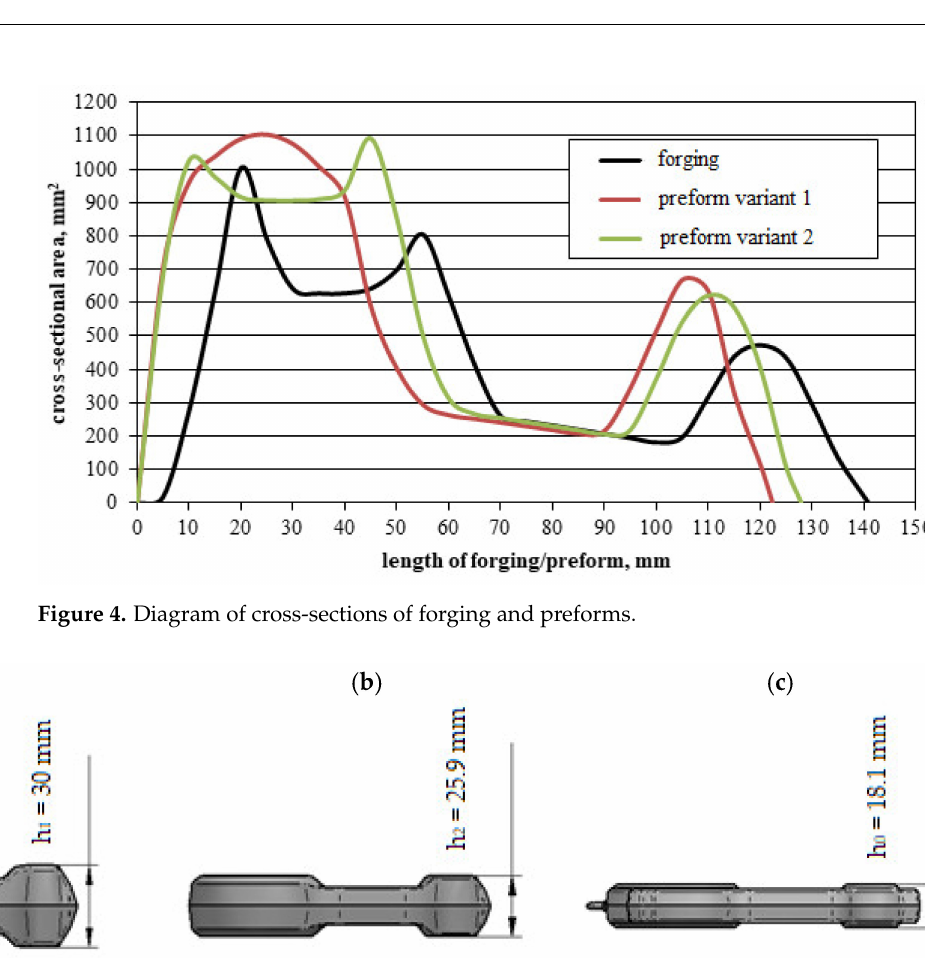
Figure 5. Three-dimensional model of the connecting rod preform: ( a ) variant 1; ( b ) variant 2; ( c ) forging.